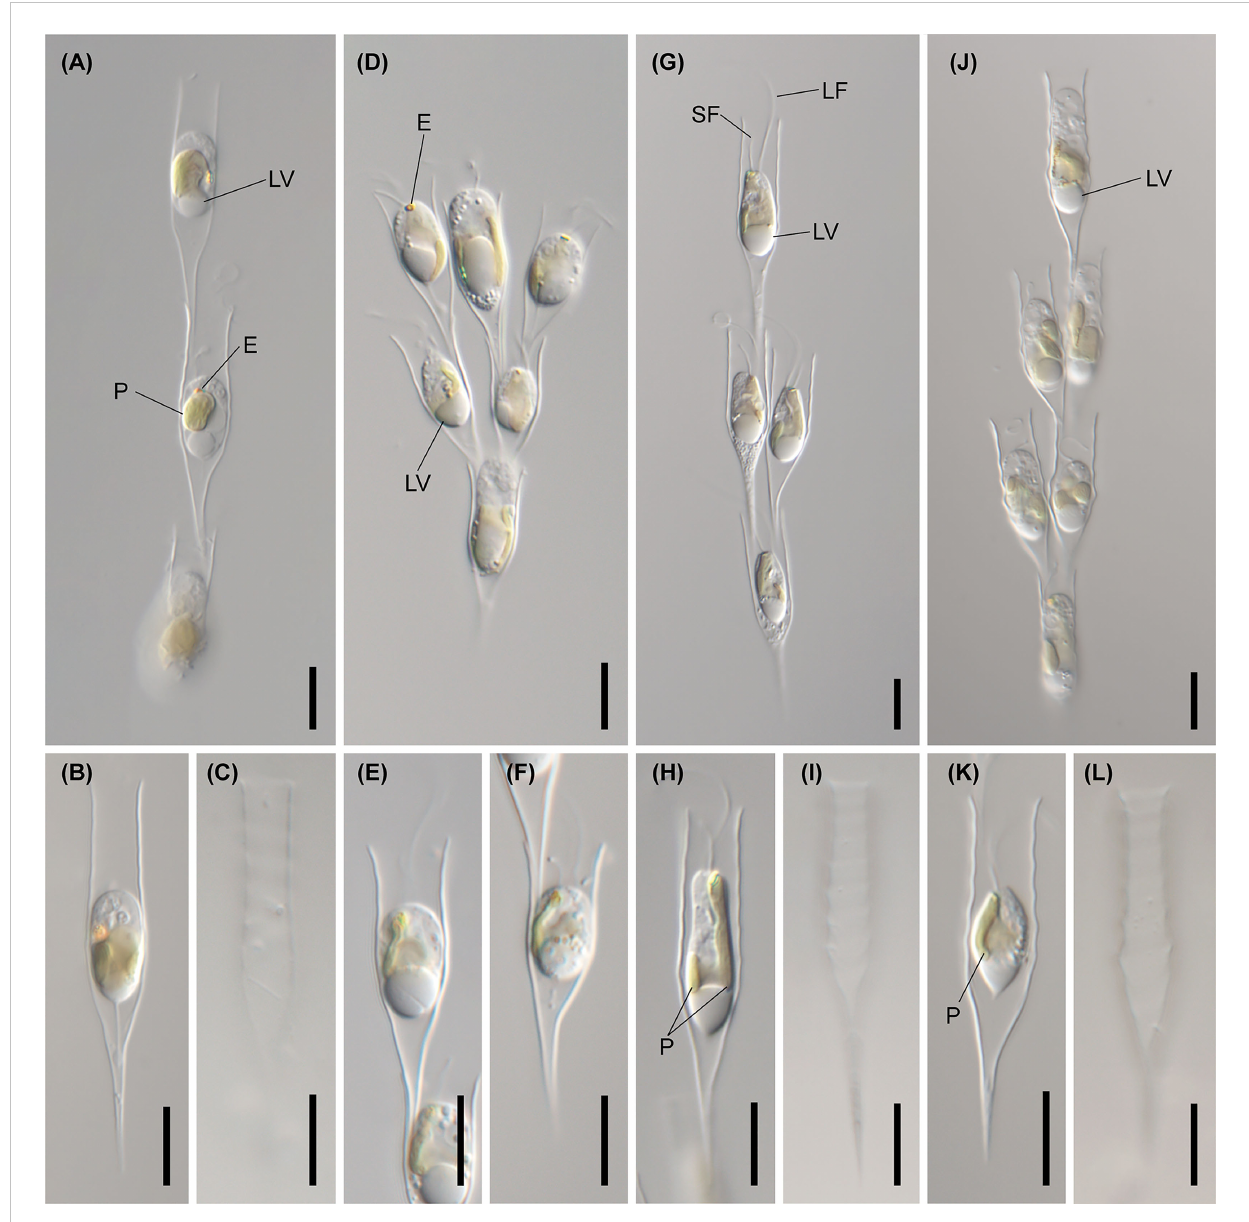
short fl agellum. Scale bars = 10